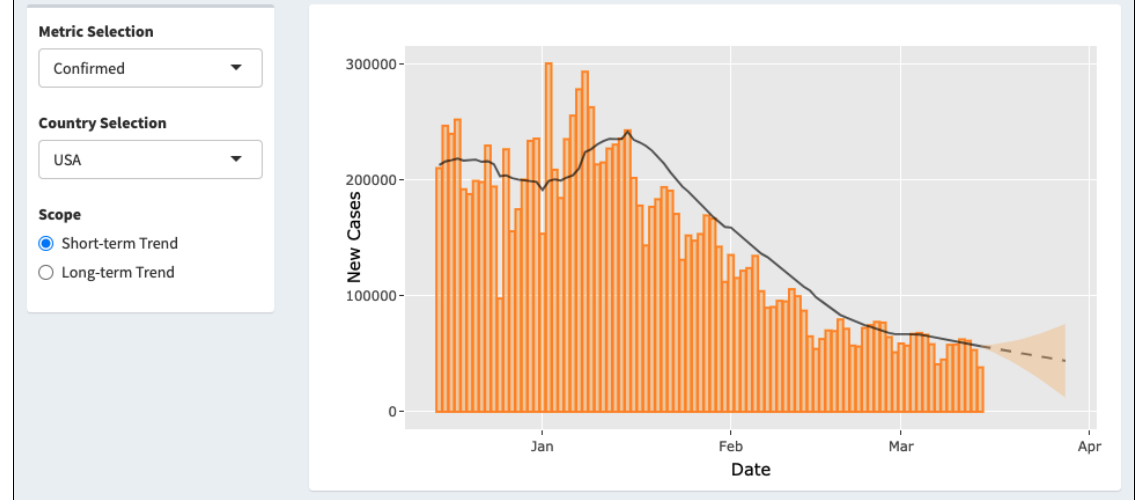
Figure 9. New Confirmed Cases Short-term Trend in USA